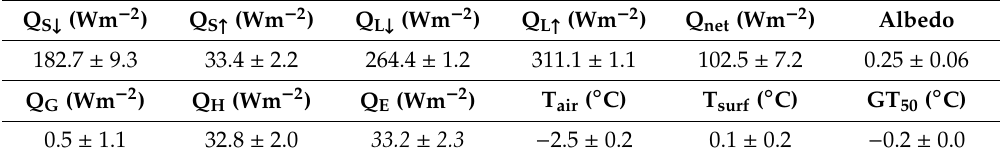
Table A1. Mean values and 95% confidence interval of selected meteorological variables on James Ross Island during 23 January to 21 March 2018. Shortcuts explanation: shortwave downward radiation (Q S ↓ ), shortwave upward radiation (Q S ↑ ), longwave downward radiation (Q L ↓ ), longwave upward radiation (Q L ↑ ), net radiation (Q net ), albedo, ground heat flux (Q G ), sensible heat flux (Q H ), latent heat flux (Q E ), air temperature (T air ), ground surface temperature (T surf ) and ground temperature at depth of 50 cm (GT 50